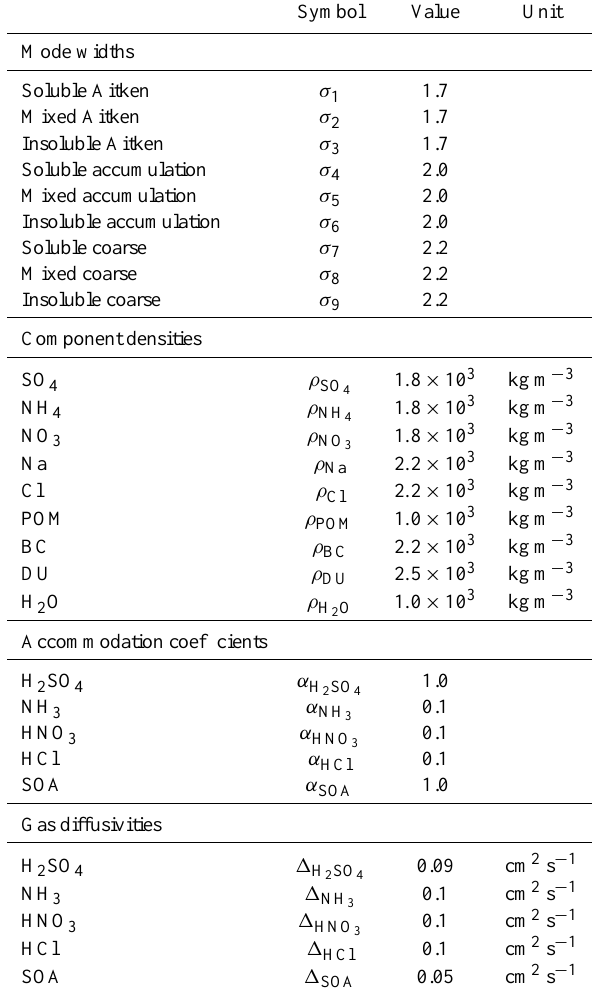
Table 1. Parameters used in MADE3: mode widths, bulk aerosol component densities, accommodation coefficients for gas adsorp- tion on aerosol particles, and diffusivities of gases in air. Abbrevi- ations are as follows: POM for particulate organic matter, BC for black carbon, DU for mineral dust, and SOA for secondary organic